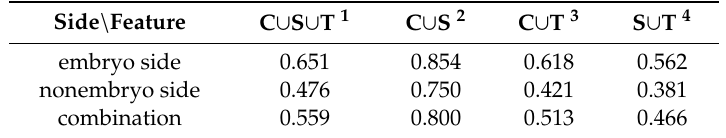
Table 2. Comparison of class separability based on optical features of sweet corn